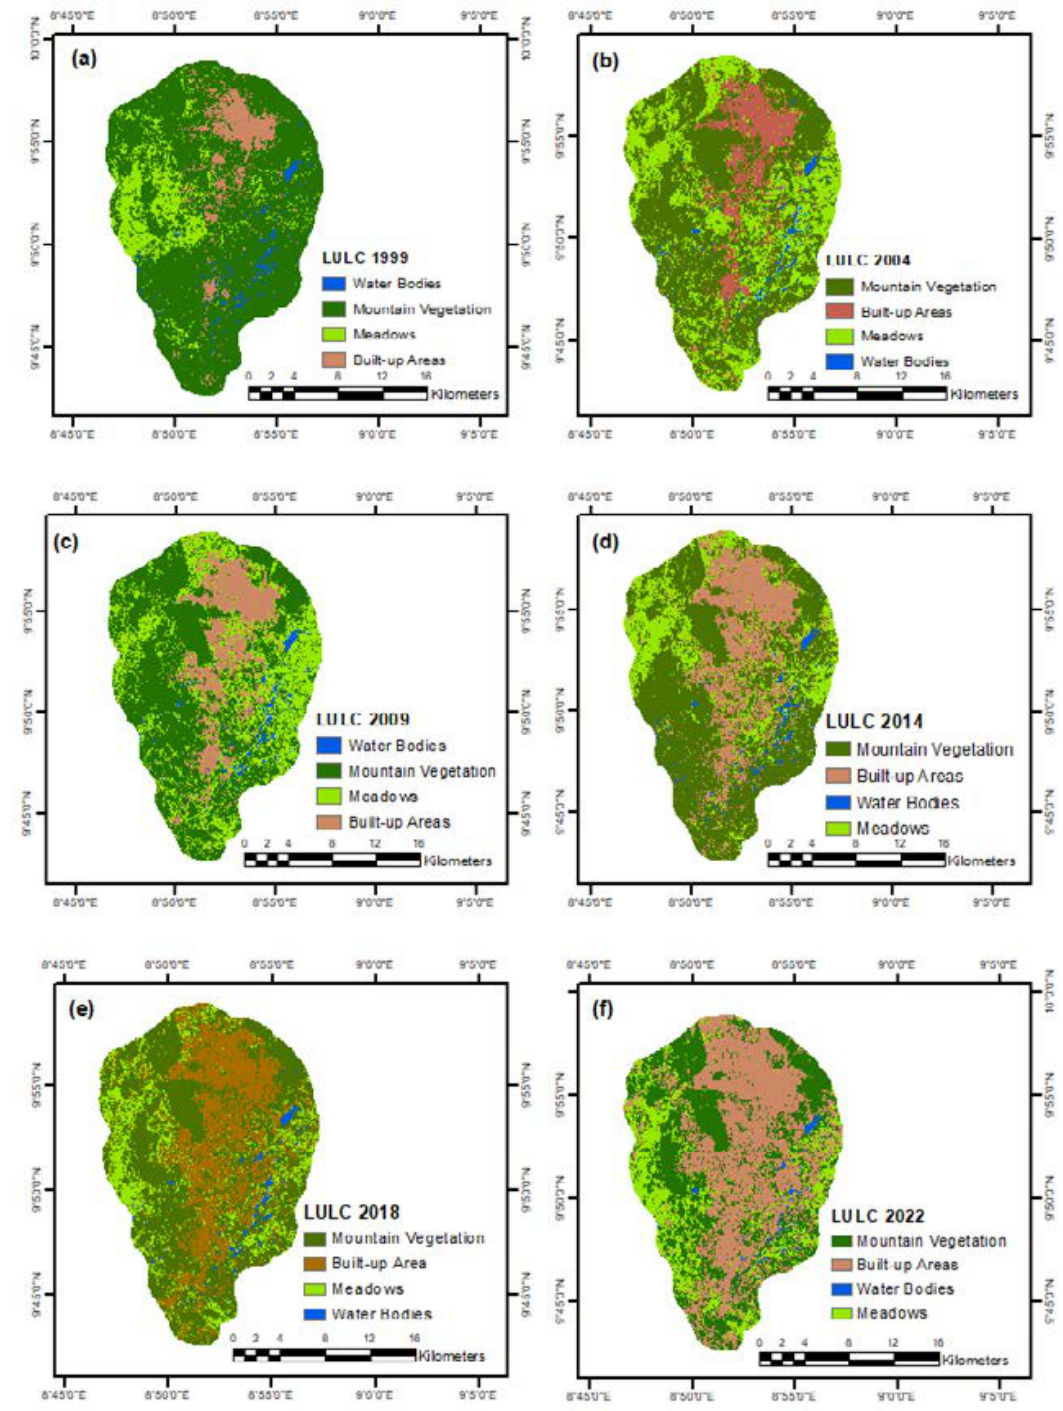
Fig. 3: LULC of Metropolitan Jos from 1999 to 2022.